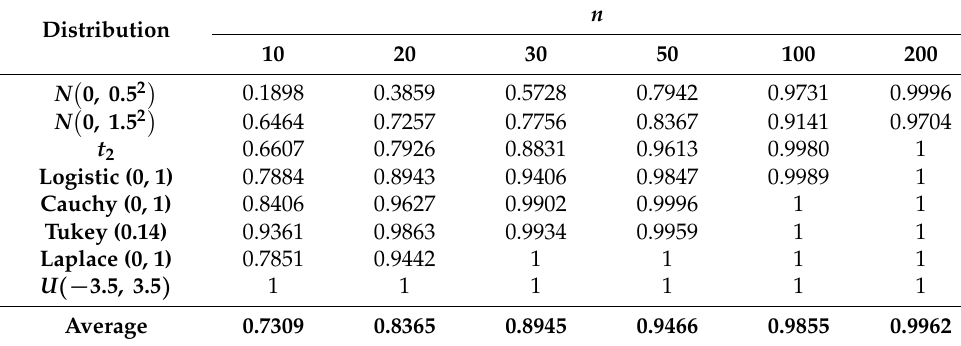
Figure 5. Statistic 𝑉(cid:3364) (cid:3041) values 𝑞 for various sample sizes 𝑛 and probabilities 𝑝 : ( a ) Parameters 𝜇 and 𝜎 (cid:2870) are known; ( b ) Parameters 𝜇 and 𝜎 (cid:2870) are estimated with 𝑋(cid:3364) (cid:3041) and 𝑆(cid:4634) (cid:3041) (cid:2870) , respectively. are known; ( b ) Parameters µ and σ 2 are estimated with X n and (cid:101) S 2 n , respectively. Table 5. Empirical power of statistic V n where parameters are estimated, for various sample sizes with the level of significance α = 0.05—Symmetric alternative